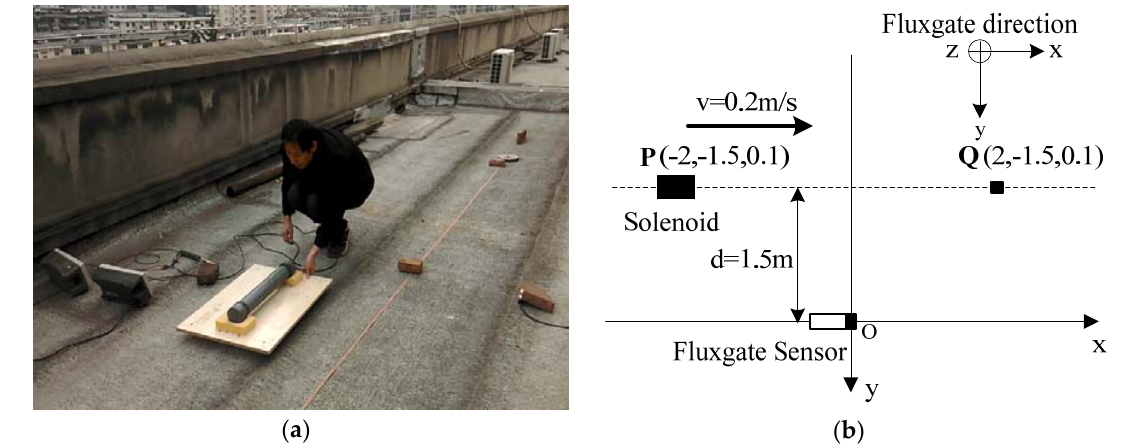
Figure 8. ( a ) Experimental tests; ( b ) Overhead view of experimental tests.